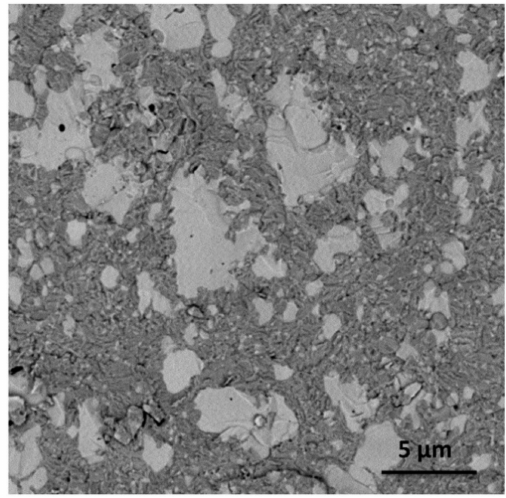
Figure 3. Fracture surface of ZrO 2 / Zr composite obtained by SPS after the bending